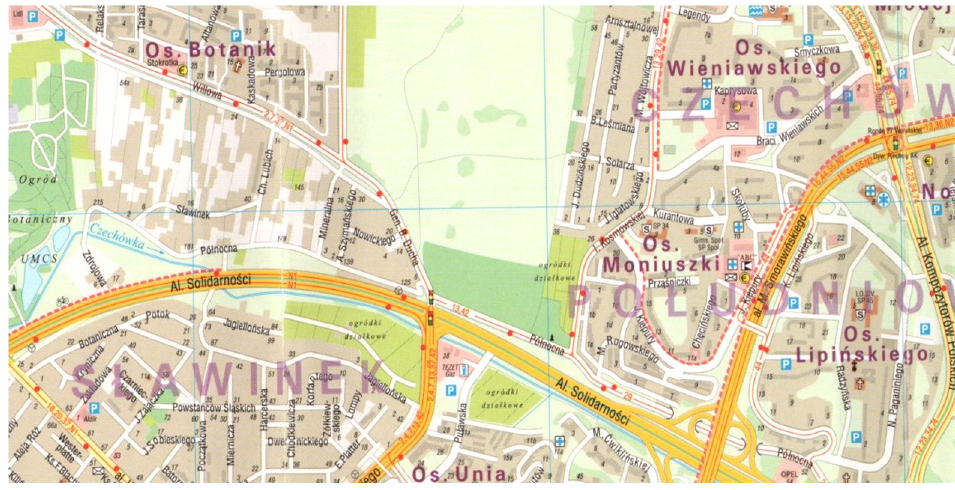
Fig. 3. Północna Street on the city map of Lublin,